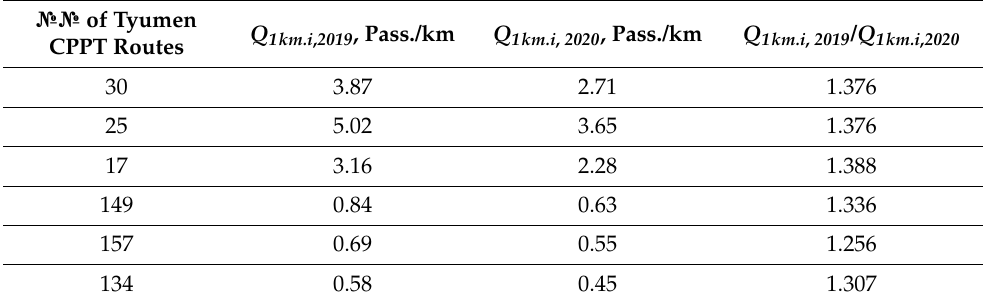
Table 14. Change of values of the expected value of Q 1 к m. i of Tyumen CPPT routes in 2020, compared with values of the expected value of Q 1 к m. i of Tyumen CPPT routes in 2019. №№ of